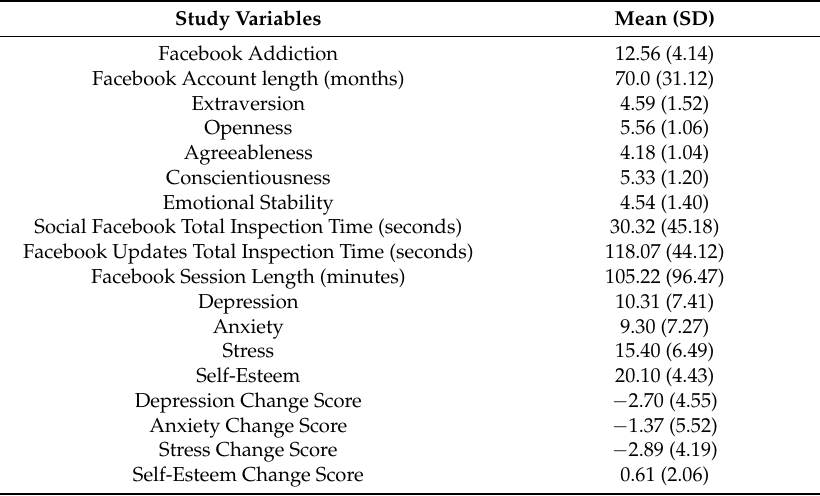
Table 1. Means (standard deviations) for study variables.